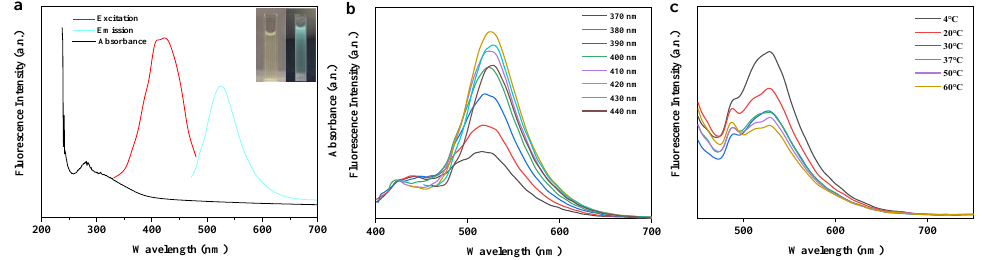
Figure 2. The optical properties of BRF. ( a ) Ultraviolet-visible (UV-vis) absorption, fluorescence excitation and emission spectra of BRF. Insert: images of the BRF observed under sunlight and UV light (365 nm), respectively; ( b ) fluorescence emission spectra of BRF with irradiation of various excitation wavelengths; ( c ) effect of temperature on the fluorescence intensity of BRF at the emission of 524 nm.